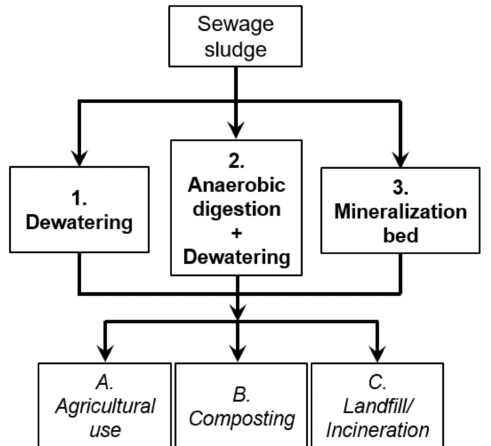
Figure 2. Surplus sludge management in Danish WWTP, according to [43]. The treatment methods are in bold, while disposal methods in